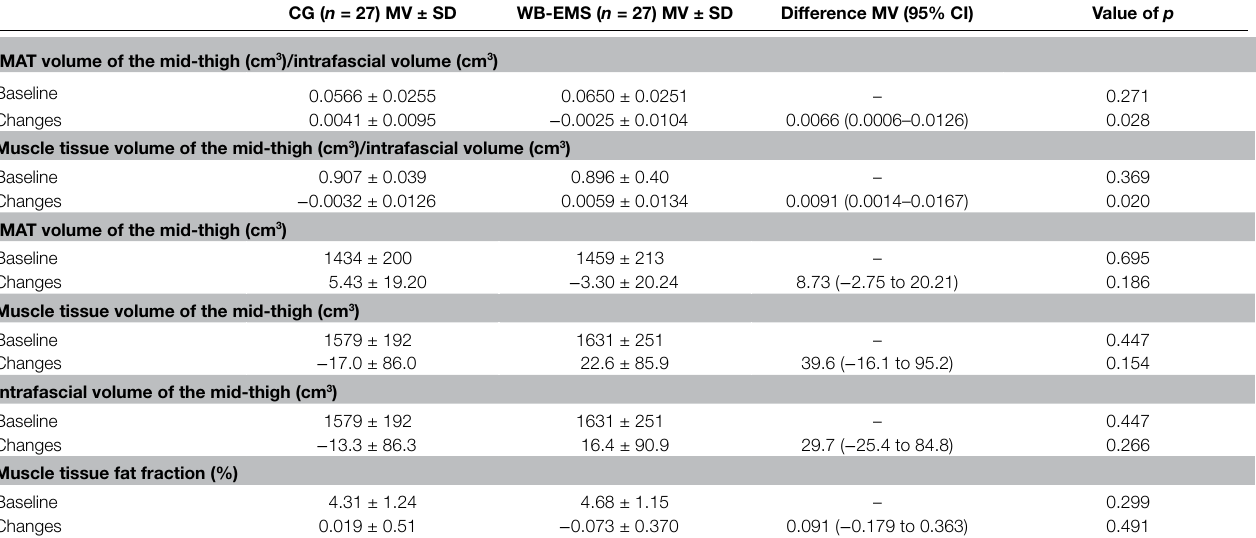
TABLE 2 | Baseline data and changes of study outcomes in the WB-EMS and control